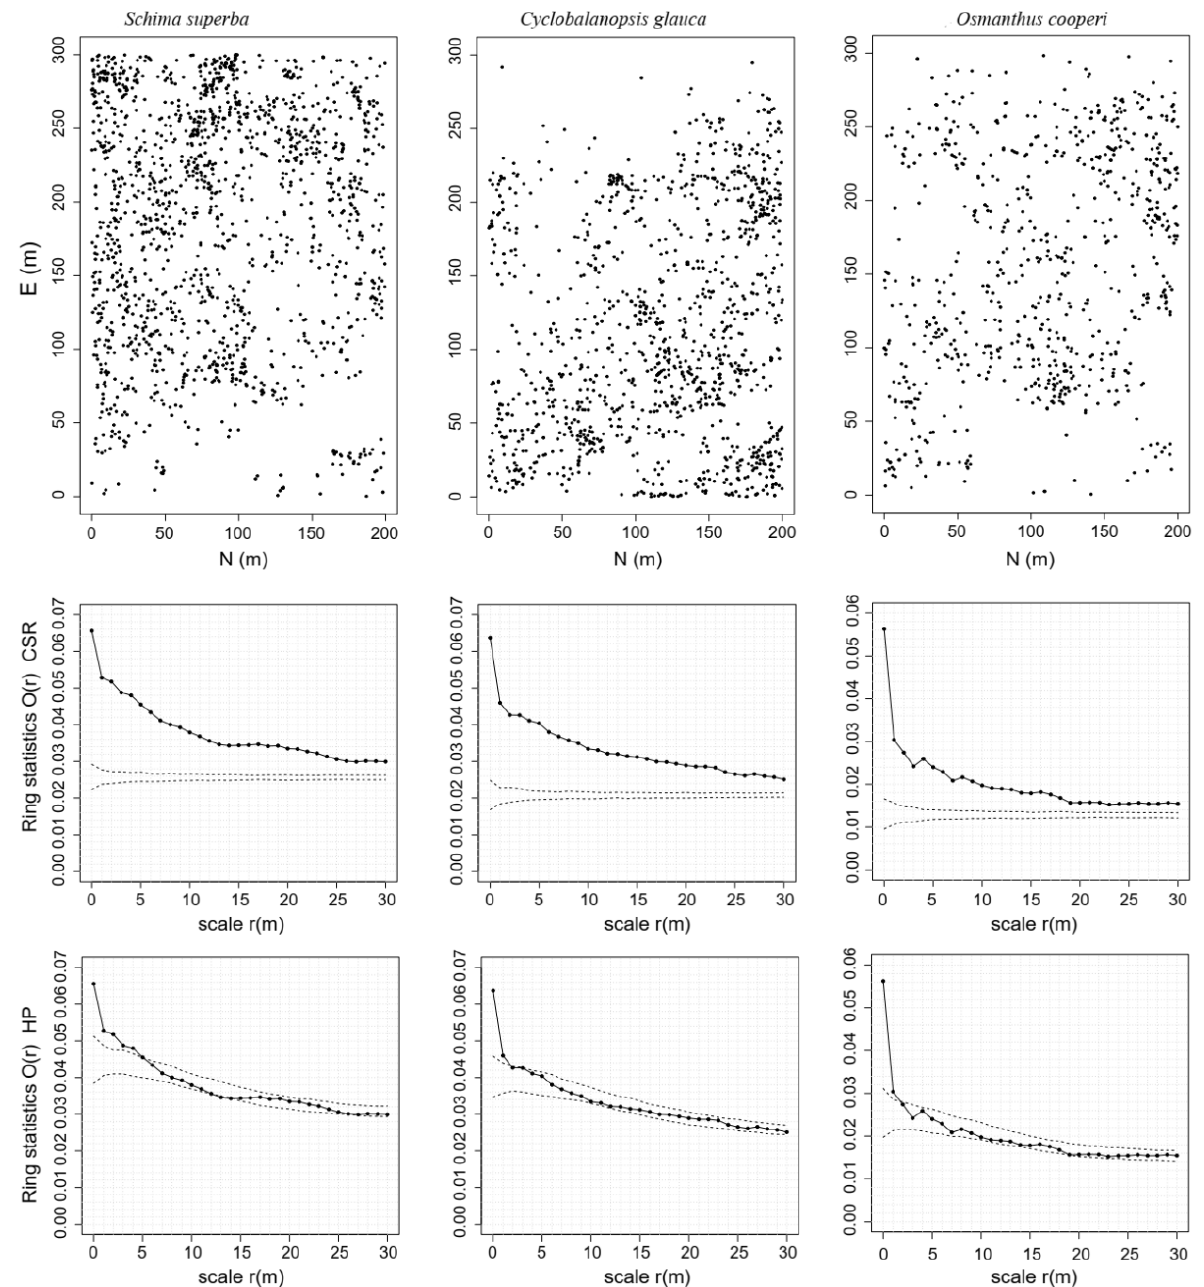
Figure 2. Spatial distribution scatters diagram and univariate point pattern analyses of Schima superba , Cyclobalanopsis glauca , and Osmanthus cooperi . Note: Black lines indicate the g11(r) function, and dotted lines indicate the upper and lower limits of the 99% confidence interval. Observed values above the upper limits indicate aggregation, within the intervals indicate random distributions, and below the lower limits indicate a regular/hyperdispersed pattern. The same is below.